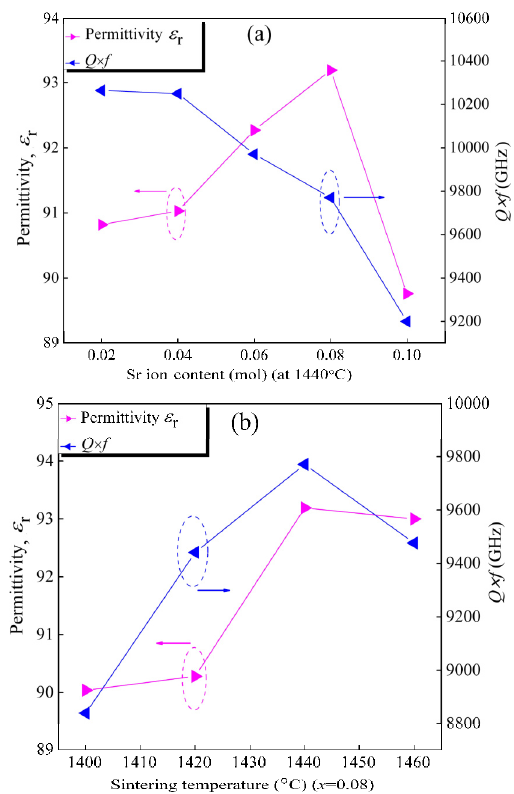
Fig. 7 (a) Influence of the Q × f value and dielectric constant (  ) of the (Ba 1 − x Sr x ) 4 (Sm 0.4 Nd 0.6 ) 28/3 Ti 18 O 54 r ceramics on the amount of Sr 2+ ions; (b) influence of the Q × f value and dielectric constant (